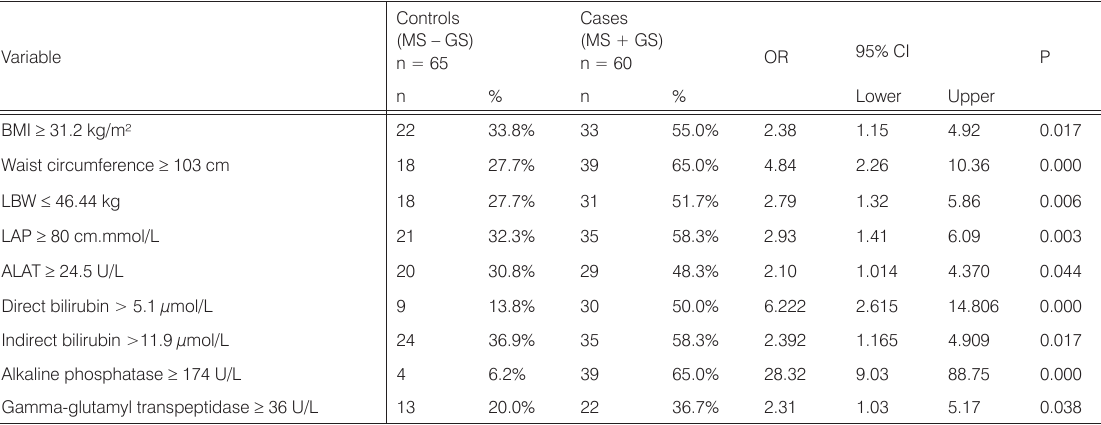
Table 2. Variables significantly associated with the probability of gallstones